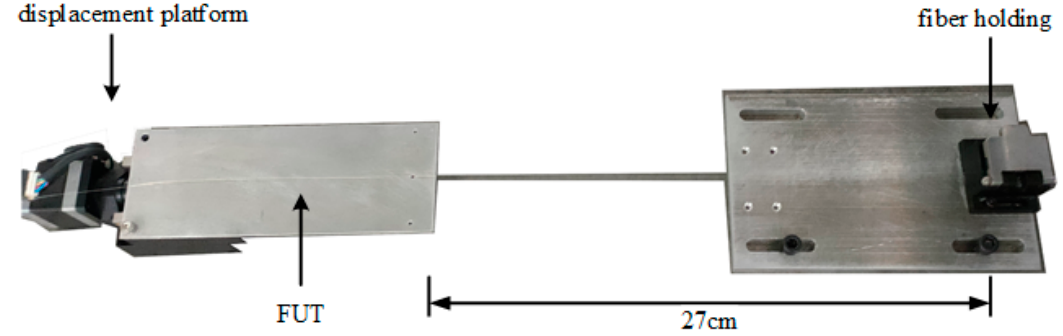
Figure 7. Structure for applying axial strain to fiber under text.